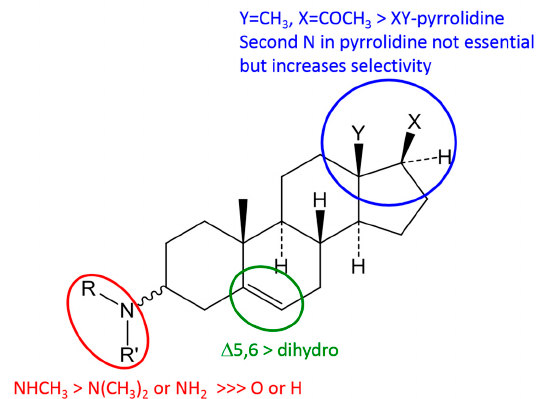
Figure 2. Proposed basic structure-activity relationships for anti-trypanosomal activity. >sign indicates higher activity.